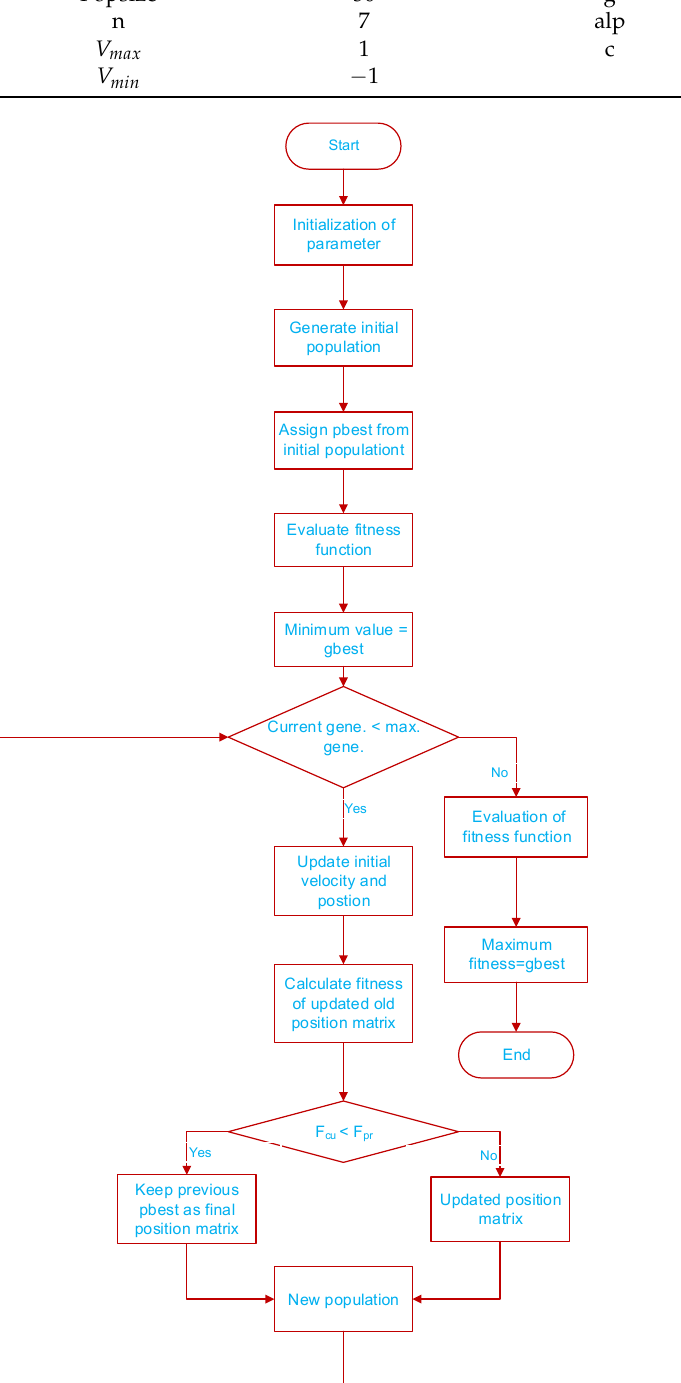
Figure 2. BPSO algorithm implementation